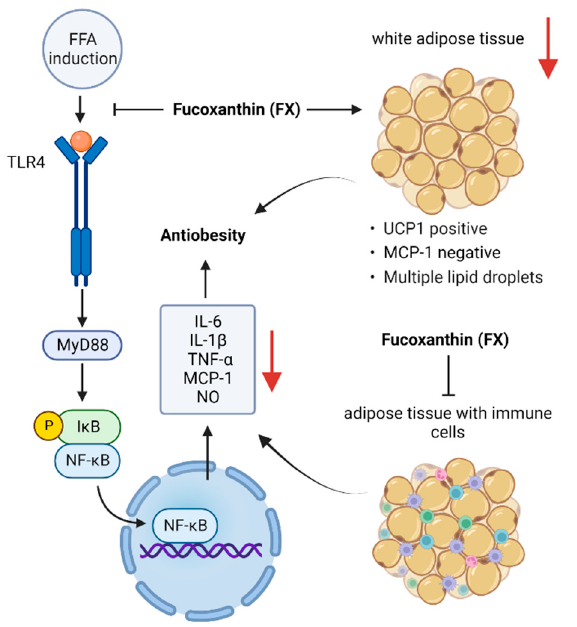
Figure 5. Pathway underlying the anti ‐ obesity effects of fucoxanthin. Free fatty acids produced by adipocytes stimulate TLR4 receptors to induce inflammation. FX inhibits NF ‐κ B entry into the nu ‐ cleus and reduces the release of inflammatory factors, such as TNF ‐α , IL ‐ 6, and MCP ‐ 1, by modu ‐ lating TLR4 receptors. FX also inhibits the release of inflammatory factors in adipocytes and macro ‐ phages infiltrating adipose tissue. Additionally, FX exerts anti ‐ obesity effects by stimulating UCP ‐ 1 expression in white adipose